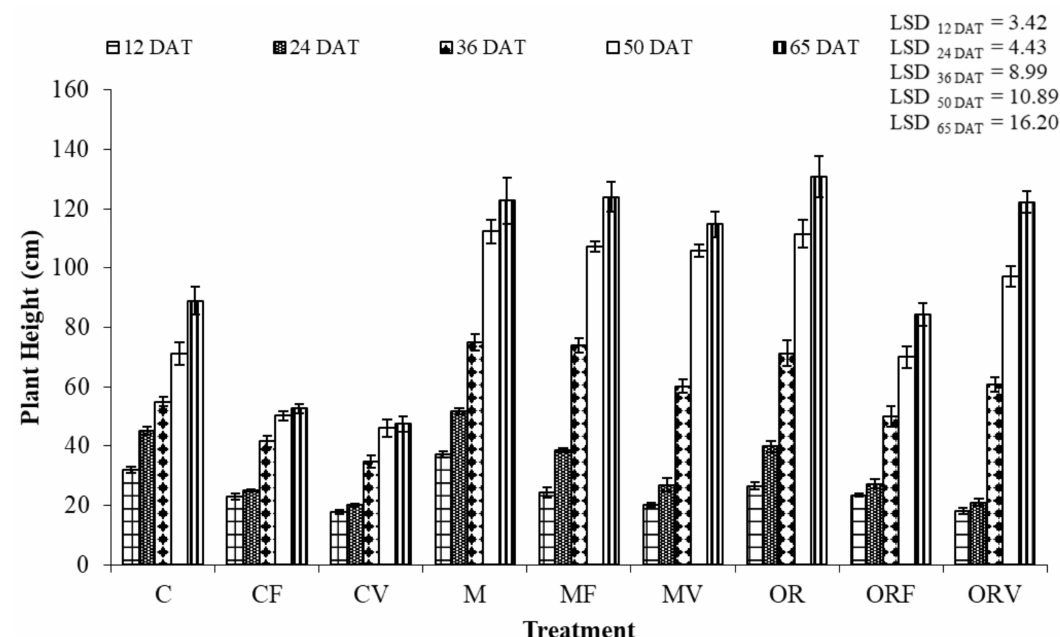
Figure 3. Plant height (means ± se) of healthy and inoculated transplanted tomatoes grown in soil amended with 4% (w / w) of spearmint or oregano plant material. Determination was made at 12, 24, 36, 50 and 65 days after the transplantation (DAT), whereas each mean represents the average of 24 determinations [12 replications (plants) × 2 experiments]. Full description of the treatments examined is found in Table 1.